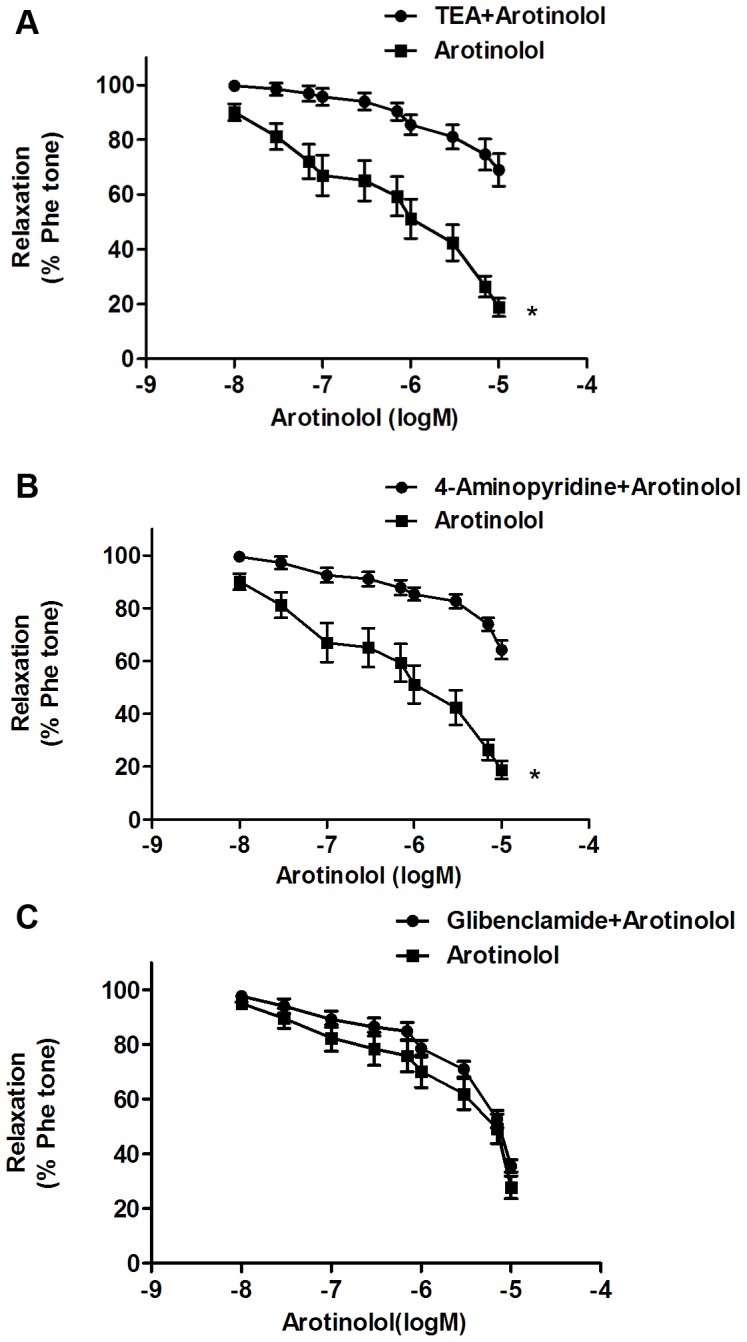
Involvement of potassium channels.(A) Cumulative concentration-response curves to arotinolol in the presence or absence of potassium channel inhibitor (TEA). *
P<0.05 for arotinolol vs. arotinolol + TEA. (B) Cumulative concentration-response curves to arotinolol in the presence or absence of 4-aminopyridine. *
P<0.05 for arotinolol vs. arotinolol + 4-aminopyridine. (C) Cumulative concentration-response curves to arotinolol in the presence or absence of glibenclamide. P>0.05 for arotinolol vs. arotinolol + glibenclamide. n = 8 in each group.